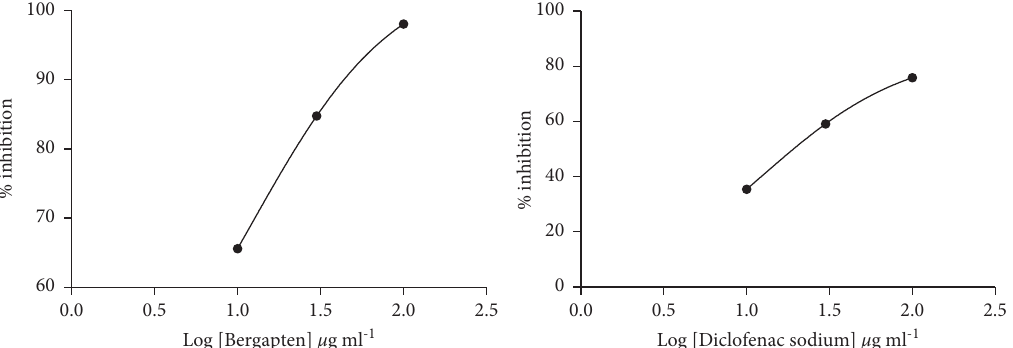
Figure 4: Dose-response curves for bergapten and diclofenac sodium in the bovine serum albumin denaturation method. Normal saline served as a negative control. Data were presented as mean ± SEM.